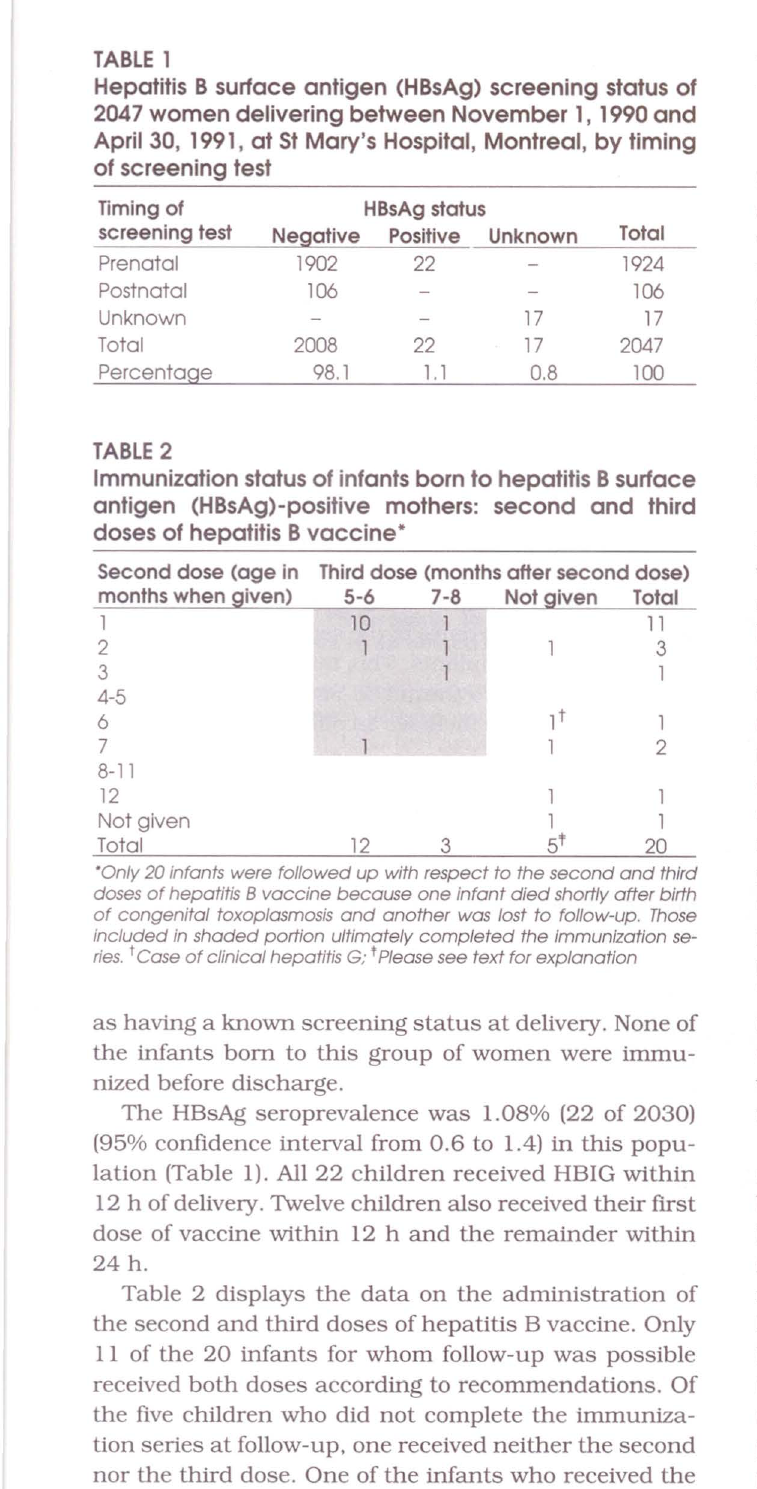
Hepatitis B surface antigen (HBsAg) screening status of 2047 women delivering between November 1, 1990 and April 30, 1991, at StMary's Hospital, Montreal, by timing